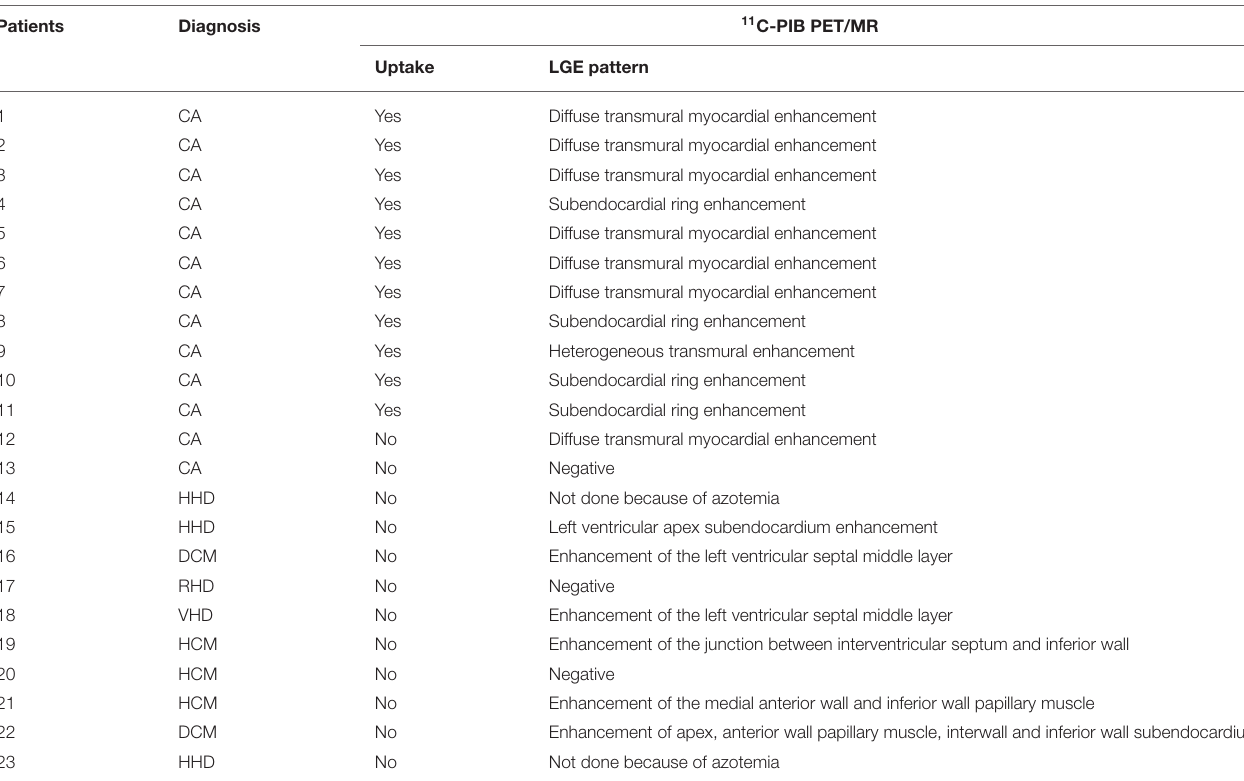
TABLE 4 | Baseline late gadolinium enhancement (LGE) patterns for all cardiac amyloidosis (CA) and non-CA patients based on 11 C-PIB PET/MR data.